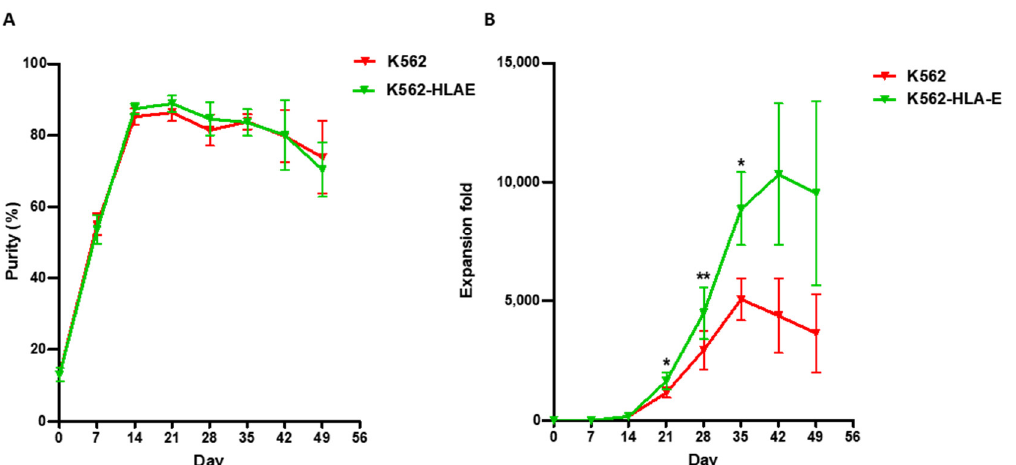
Figure 2. Purity and fold expansion of expanded natural killer (NK) cells co-cultured with K562 and K562-HLA-E. feeder cells. Freshly isolated peripheral blood mononuclear cells (PBMCs) were co-cultured with γ-irradiated K562 (red) and K562-HLA-E (green) feeder cells in the presence of IL-2 (10 U/mL) at day 0 and IL-2 (100 U/mL) and IL-15 (5 ng/mL) after 1 week. The medium was replaced every 2–3 days along with fresh cytokines. ( A ) Purity of expanded NK cells was determined by flow cytometry using fluorescein isothio-cyanate (FITC)-conjugated anti-human CD3 and phycoerythrin (PE)-Cy5-conjugated anti-human CD56. ( B ) Fold expansion of NK cells in the K562 vs. K562-HLA-E added groups was significantly different from day 21 of culture. All data are shown as the mean ± SEM ( n = 9 independent experiments; * p < 0.05; ** p < 0.01).